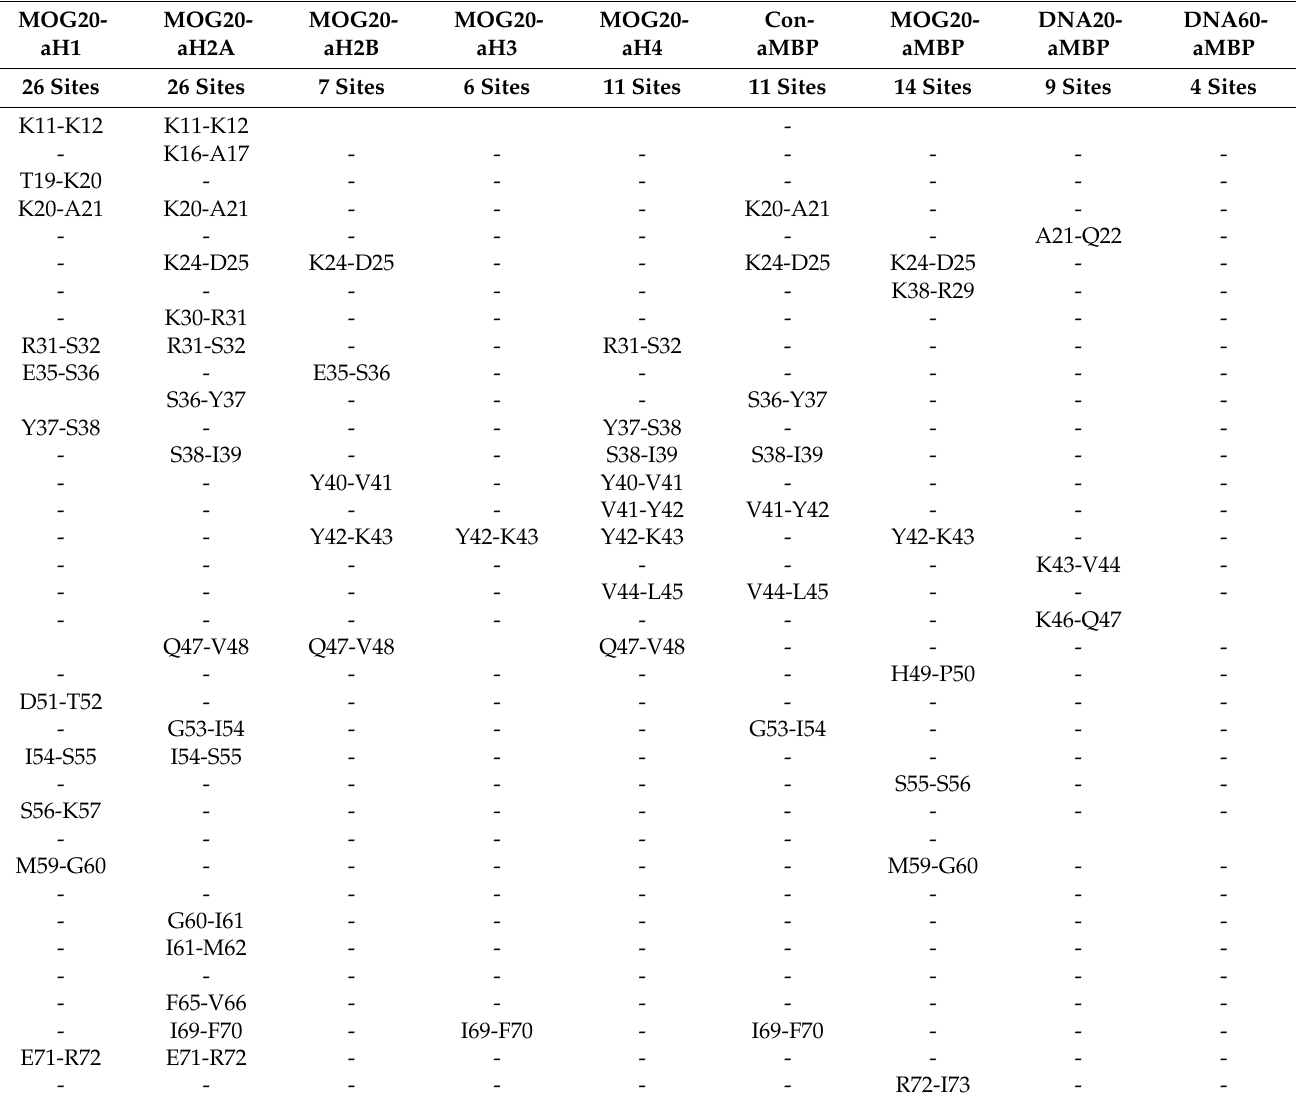
Table 3. Sites of H2B histone hydrolysis by IgGs against five individual histones 20 days after mouse immunization with MOG and IgGs against MBP